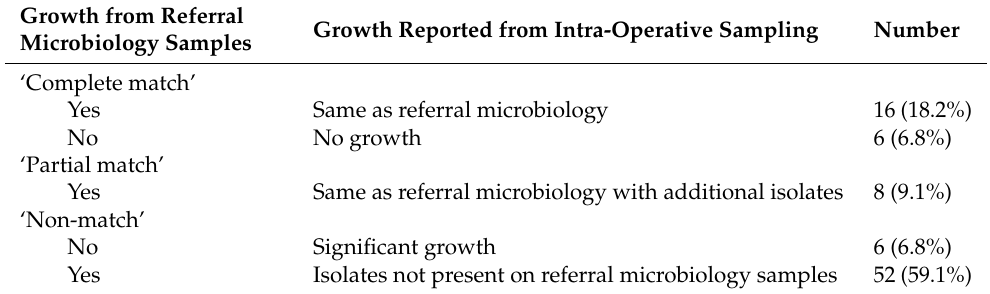
Table 2. Comparison of pre-referral microbiology to intra-operative samples in 72 patients represent- ing a total of 88 pre-referral microbiology